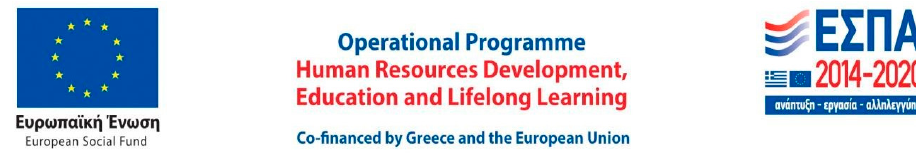
Figure S3: Web Application alert notifies about drug–drug interactions, after medication form sub- mission; Figure S4: IoMT platform Database design; Figure S5: For the study every pill compartment is numbered for easier pill indication; Figure S6: System Usability Scale and Additional